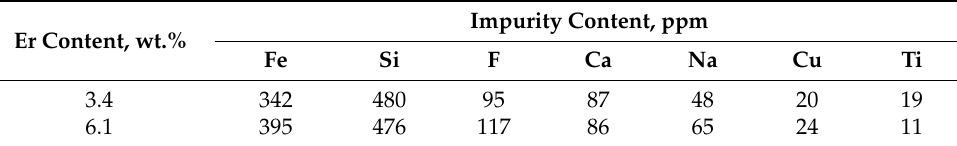
Table 3. The impurity content in the master alloy Al-Er. Er Content,